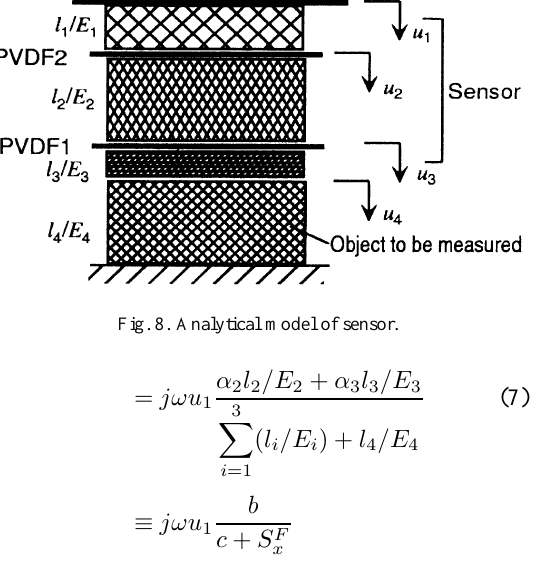
Fig. 8. Analytical model of